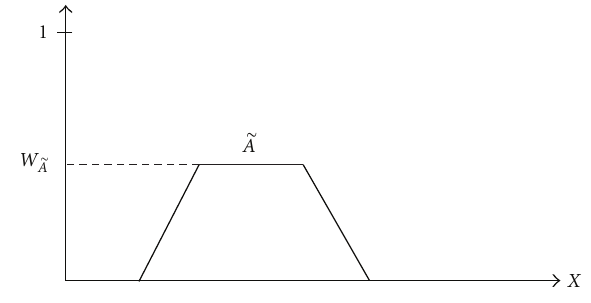
Figure 1: A generalized trapezoidal fuzzy